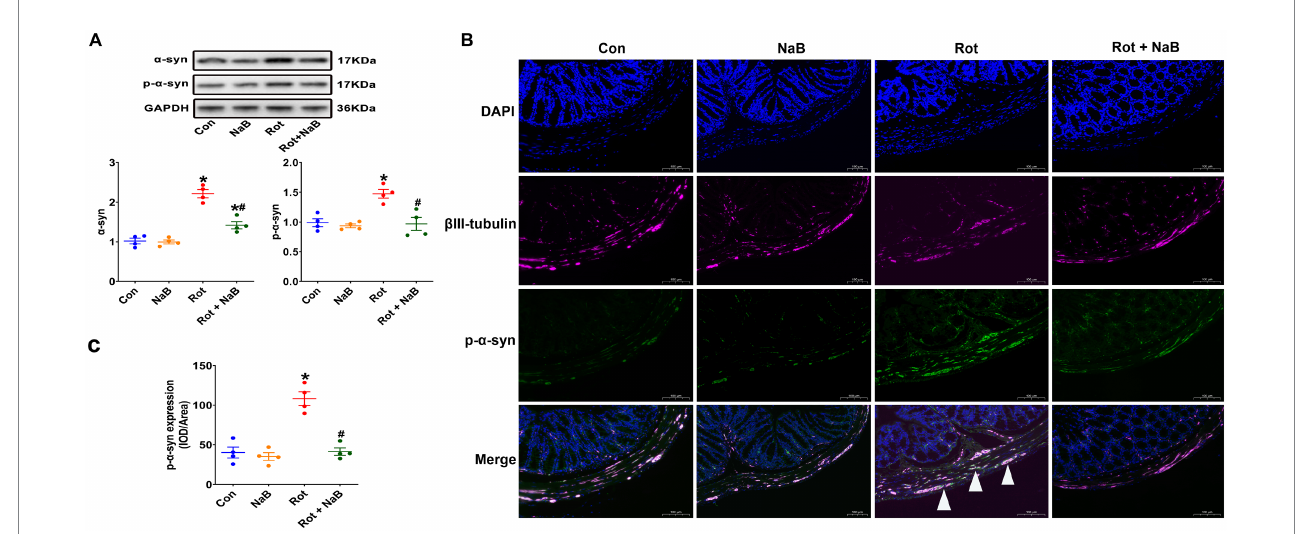
FIGURE 2 NaB alleviates rotenone-induced colonic α -synuclein pathology. (A) Representative blots of colonic α -syn and p- α -syn expression. (B) Representative photomicrographs of colon sections immunostained for DAPI, β III-tubulin, and p- α -syn. The β III-tubulin was used as the marker of colonic neurons. The presence of p- α -syn staining in colonic neurons was shown by the arrows. Scale bar = 100 μ m. (C) Quantitative analysis of the mean fluorescence intensity of p- α -syn. n = 4 per group. The data represent the mean ± SEM. * p < 0.05 vs. Con group; # p < 0.05 vs. Rot group. α -syn: α -synuclein; Con: control; IOD: integrated optical density; NaB: sodium butyrate; p- α -syn: phospho-Ser129 α -synuclein; Rot: